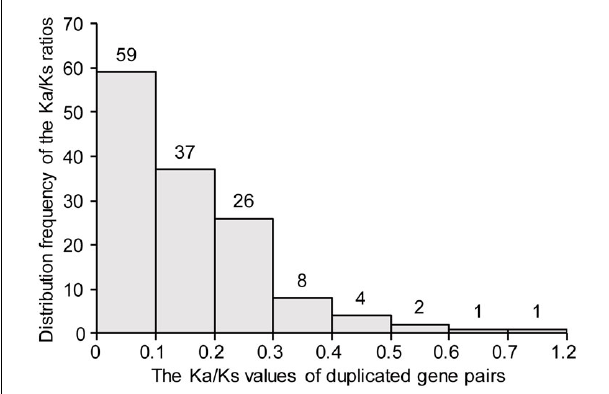
FIGURE 4 | Histogram of distribution frequency of pairwise Ka/Ks ratios for duplicated TaDEAD-box genes. Ka, nonsynonymous substitution rate; Ks, synonymous substitution